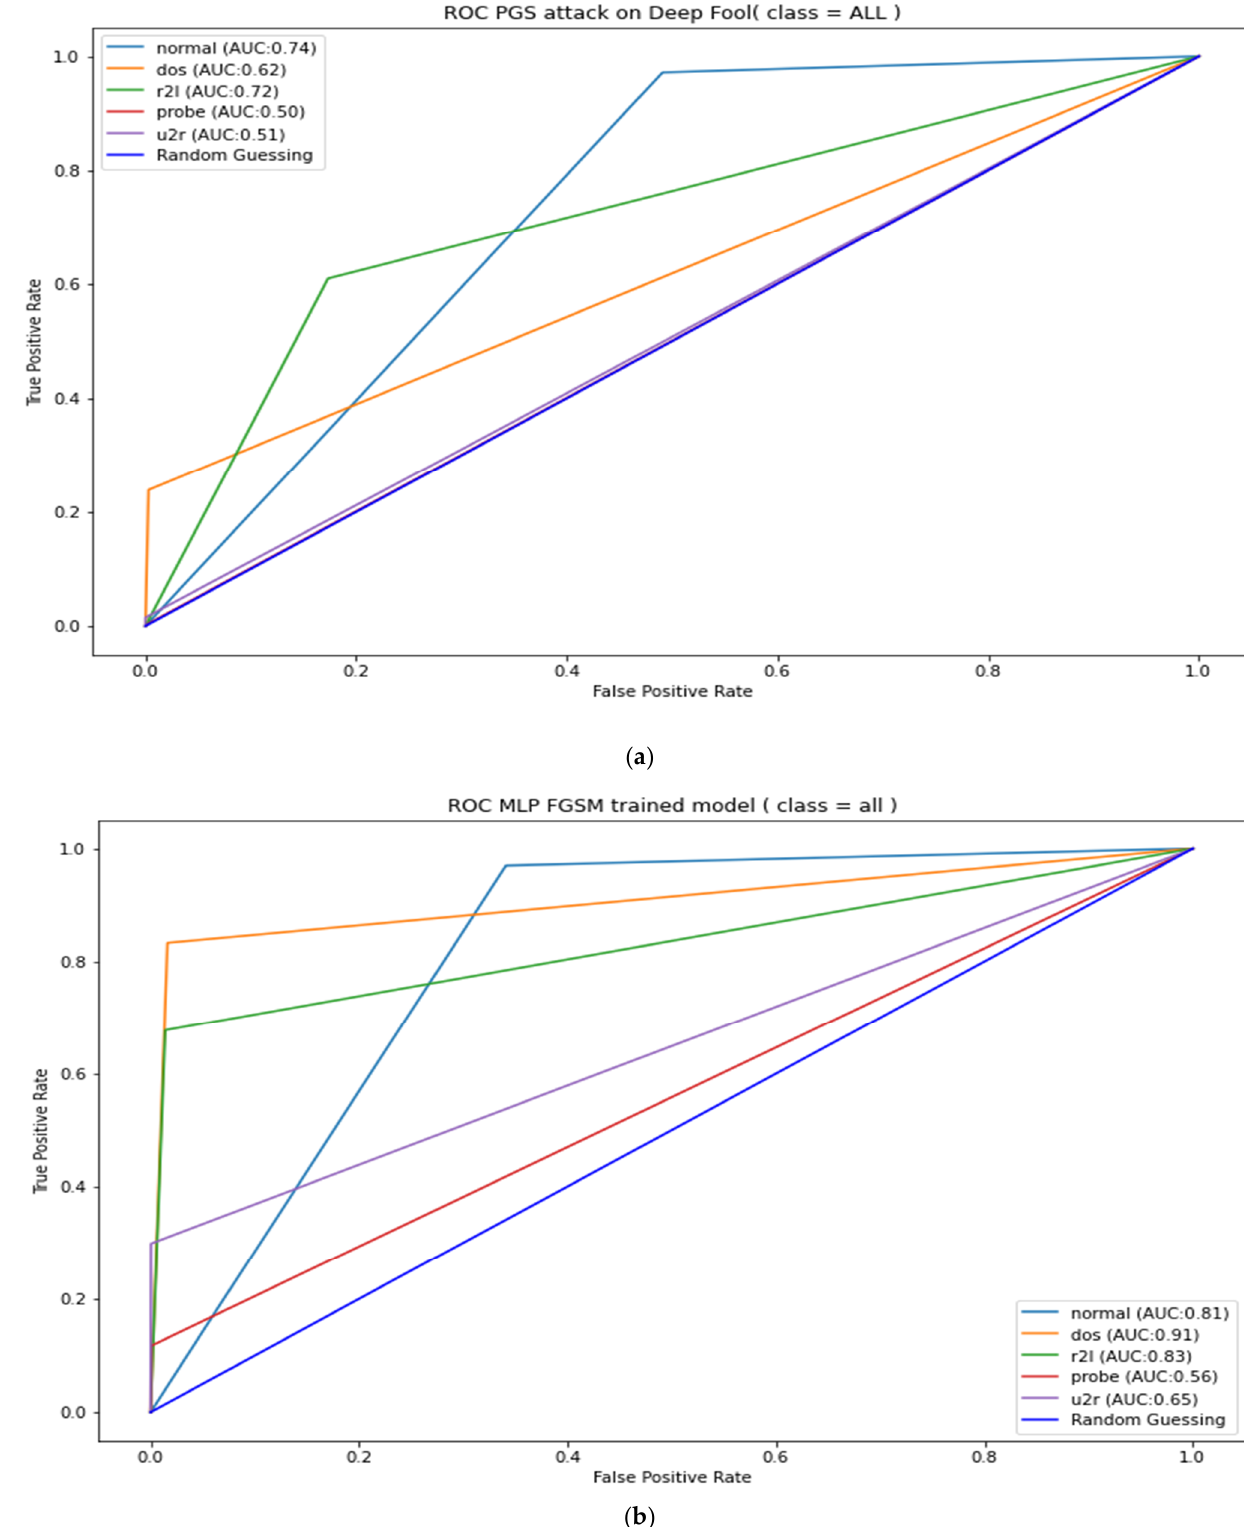
Figure A2. DeepFool robustness test against PGD attacks ( a ). FGSM adversarial-trained model ROC-AUC ( b ).